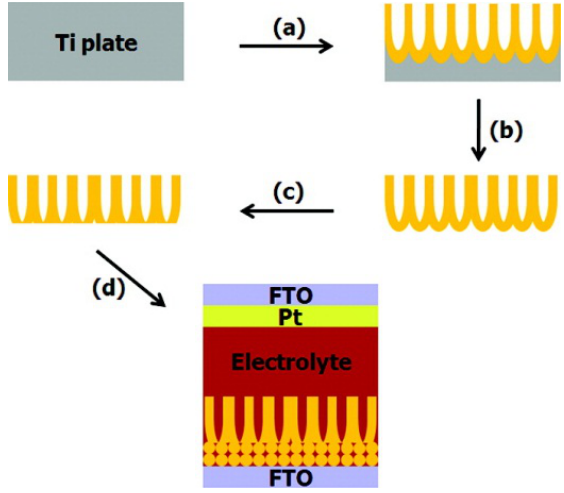
Figure 13. Scheme illustrating the transferal of a nanotube array from titanium foil to FTO glass coated with TiO nanoparticles for adhesion. Process ( a ) is the anodization; ( b ) the 2 nanotube removal; ( c ) the removal of the barrier layer; and ( d ) the adhesion to FTO glass. Reprinted with permission from [87]. Copyright 2012 American Chemical